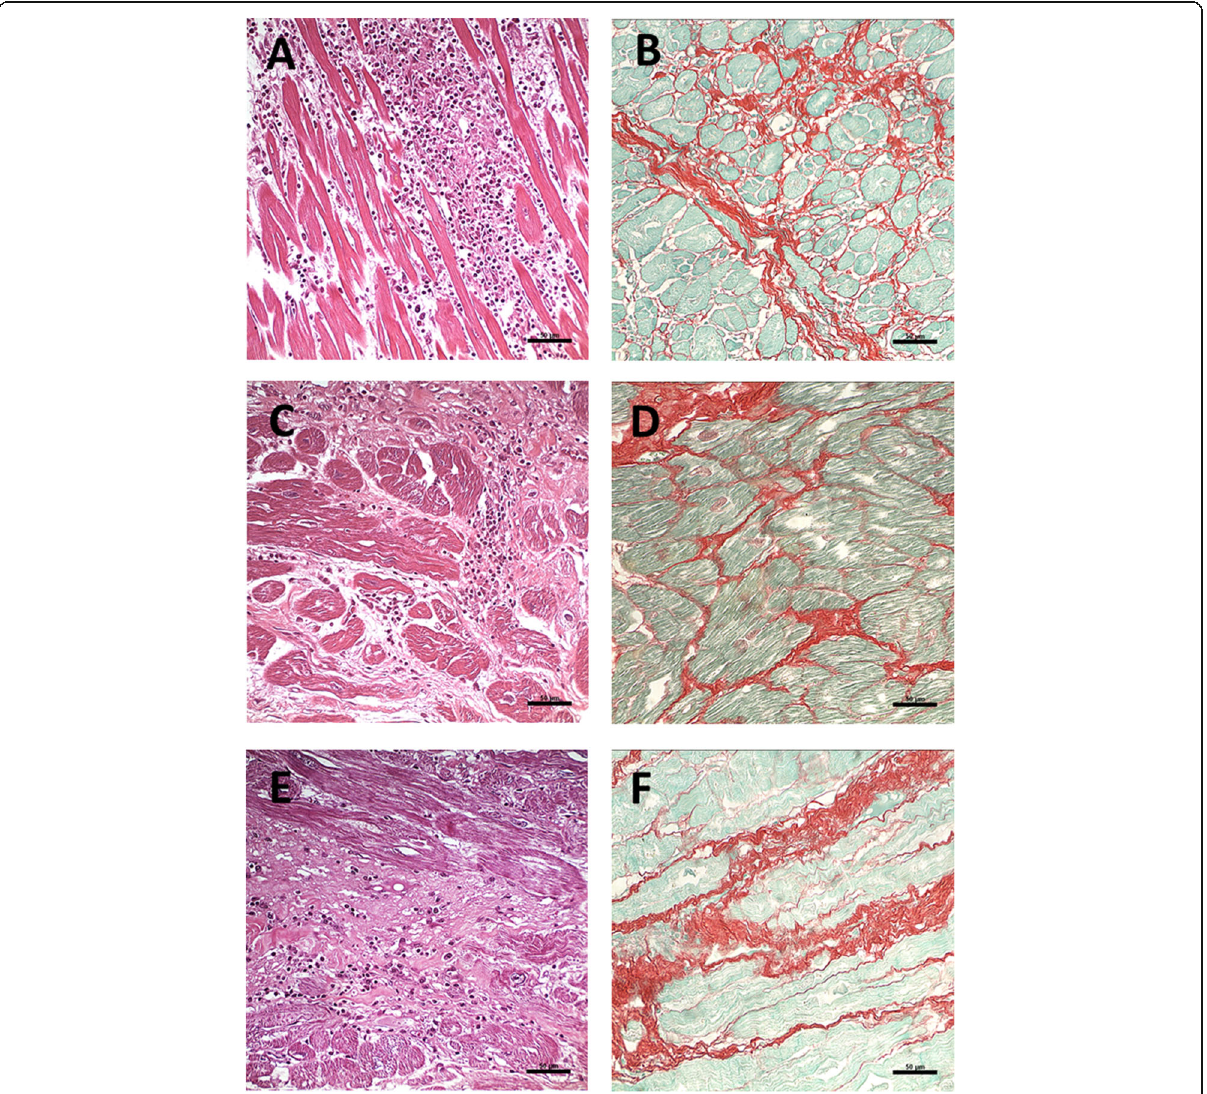
Fig. 4 Presence of inflammation and fibrosis in explanted hearts from subjects with CCC. Heart sections of explants from three subjects with CCC were prepared. a , c and e , Staining with H&E, showing multifocal inflammatory infiltrate composed by mononuclear cells. b , d and f , Sirius red staining, showing extensive areas of interstitial